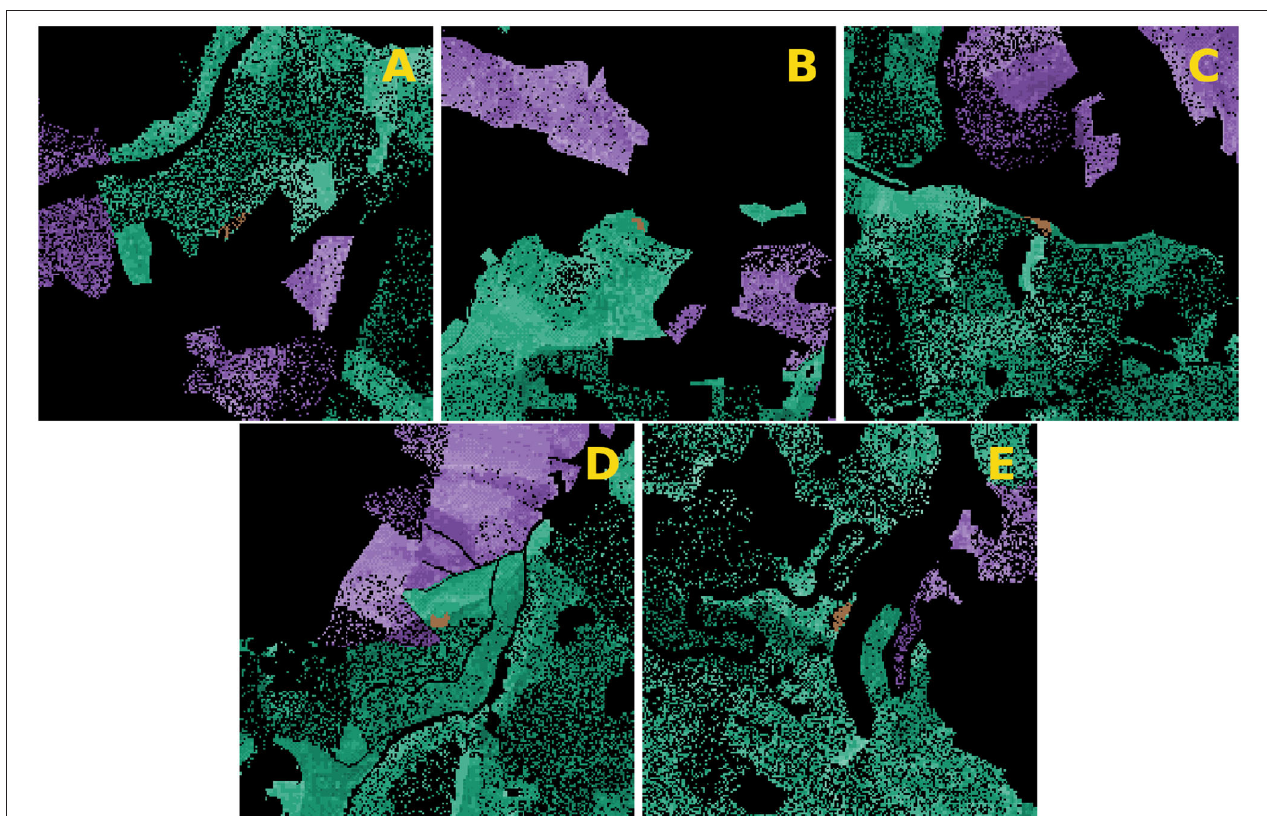
FIGURE 3 | Representation of the five research sites (labeled A–E ) used for the application of IPS-SPREADS. All spruces outside the NLP (national park) are colored purple. Green, spruce trees inside NLP; brown, beetle sources; black, everything else (meadow, roads, other tree species).